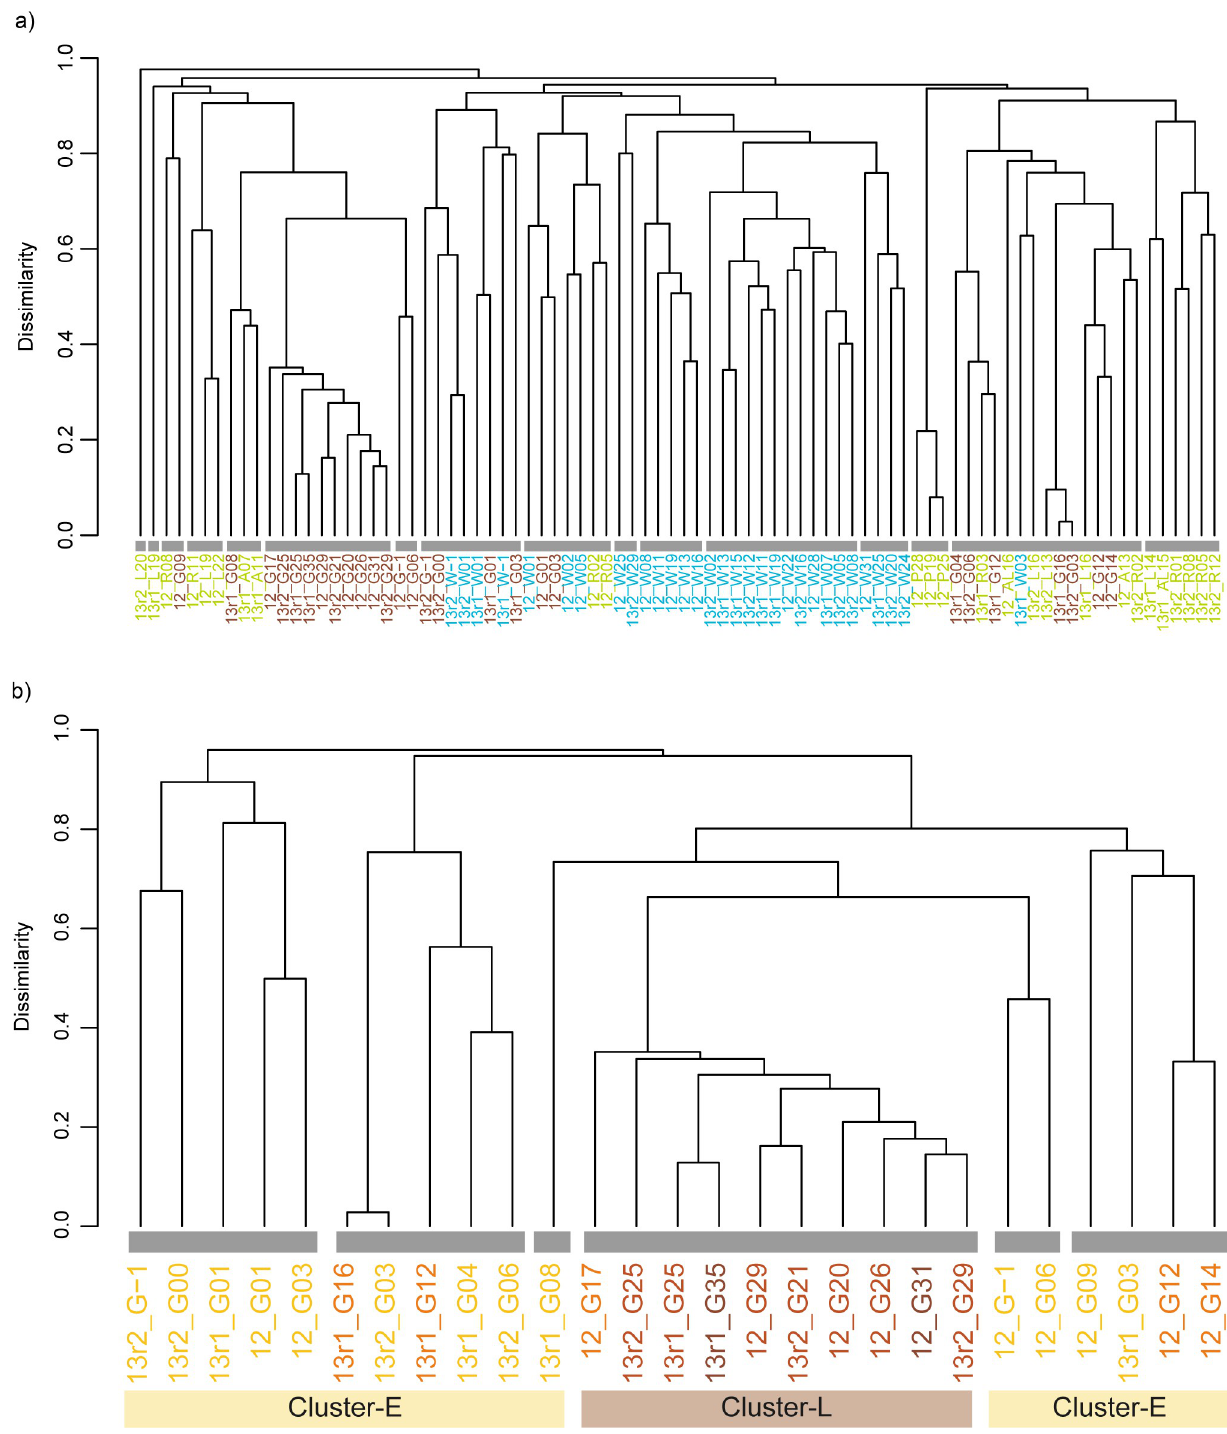
Fig 1. Cluster analysis of bacterial community structures. (a) Cluster constructed using all samples, rearing water (blue letters), feed (green letters) and intestine (brown letters). (b) Cluster constructed using only intestinal samples. Sample names are represented by experimental year, sample type, and DAH of bluefin tuna; 0 DAH is the day of hatching and Day -1 represents the unhatched egg. For example, 12_G17 represents intestinal samples at 17 DAH in 2012. W, water; G, intestine; R, rotifer, A, Artemia; L, feeder larvae (striped beakfish); P, commercial pellet.